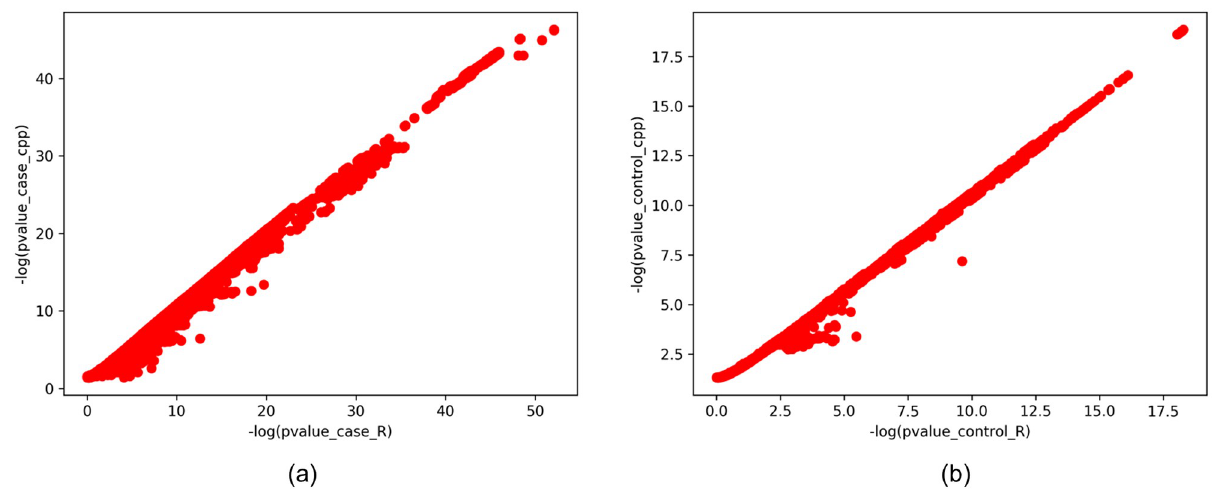
Fig 2. Comparison of log of p-values with values computed using the previous implementation in R (-log(pvalue_case_R) and -log (pvalue_control_R)) along the x-axis and the ones computed using the new implementation using C++ (-log(pvalue_case_cpp) and -log (pvalue_control_cpp)) along the y-axis, for k-mers positively correlated with (a) cases, and (b) controls.